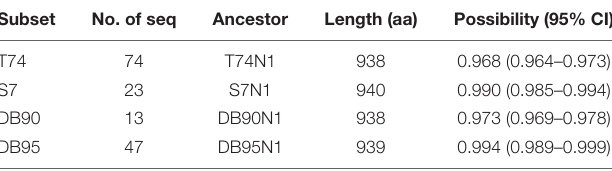
TABLE 2 | Confidential of ancestral sequence based on different datasets. Subset